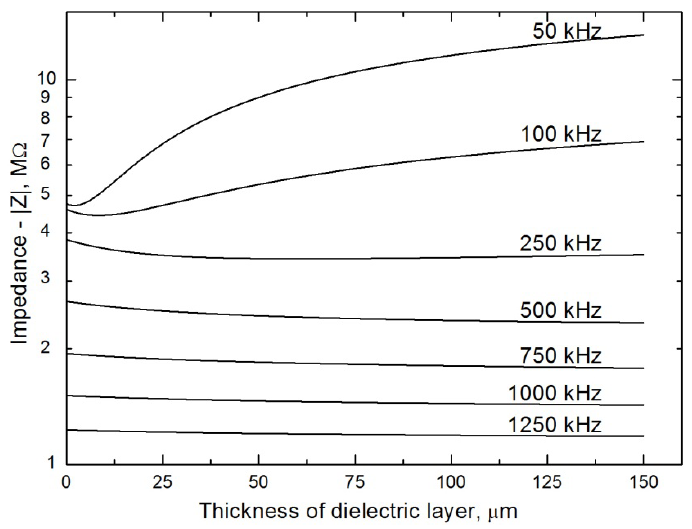
Figure 6. Model dependences of the impedance on the thickness of the dielectric layer in the range from 0.1 to 150 μ m for various input voltage frequencies (specified next to the curves, in kHz). Model calculations are based on the equivalent circuit in Figure 1, which was employed for a tubular cell (Figure 2A). The modeling parameters are: silica capillary, = 37.5 μ m, thickness of capillary wall 0.1–150 μ m, ε (fused-silica) = 4.3; inner diameter r 1 r = 0.1 pF (estimated); the capillary is filled with 20 mM d = 1 mm, w = 2 mm and C x MES/His solution, conductivity κ = 4.7 × 10 − 2 S m − 1